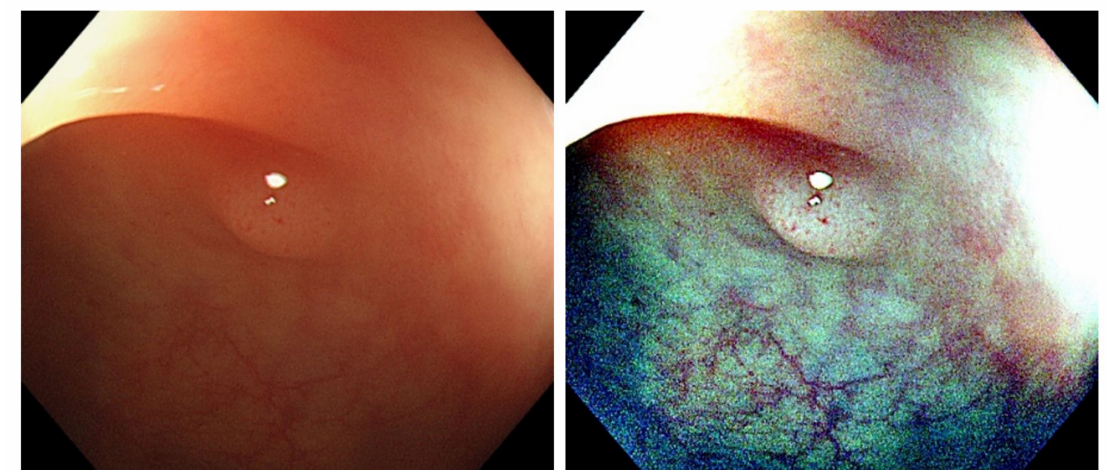
Figure 6. Images of HP polyp after Retinex (( Left ): Original WL, ( Right ): Retinex).